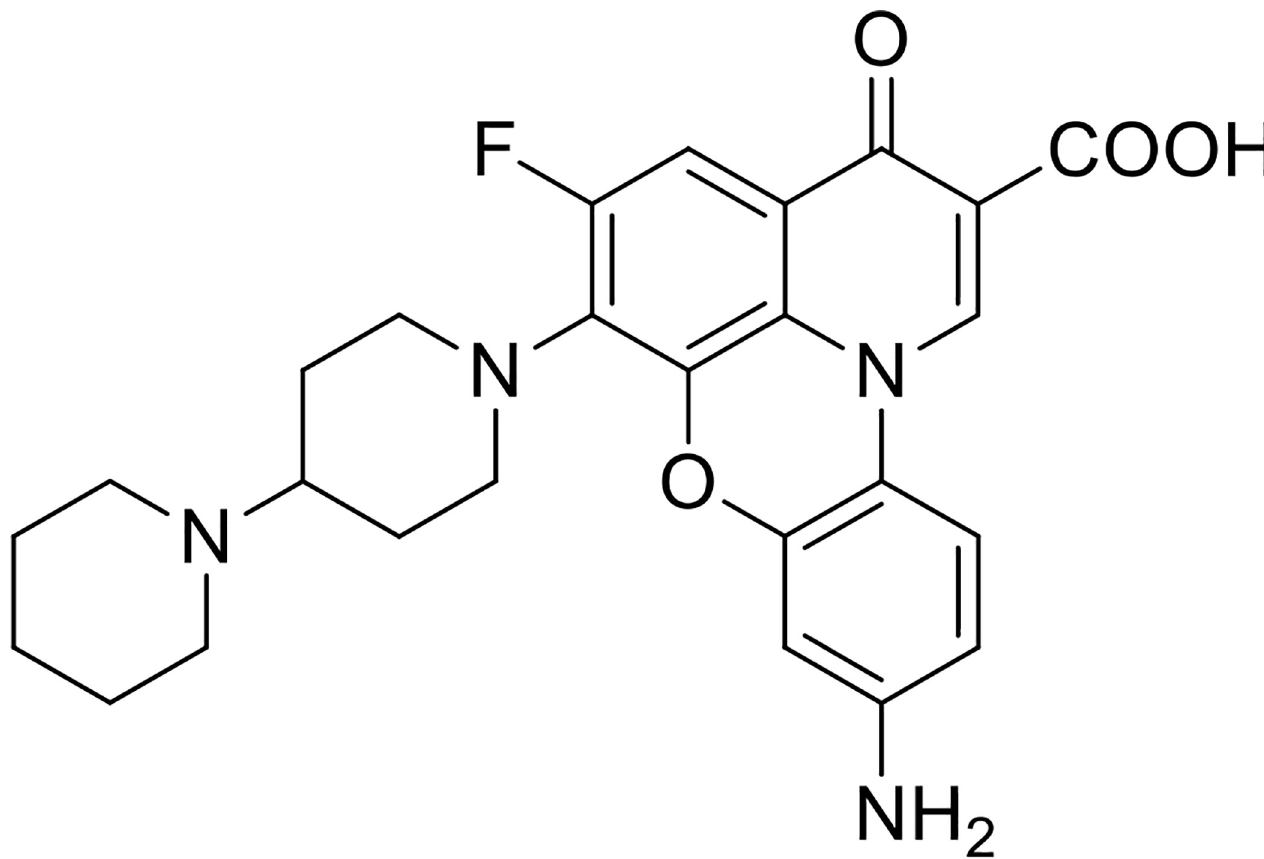
Fig 1. Structure of